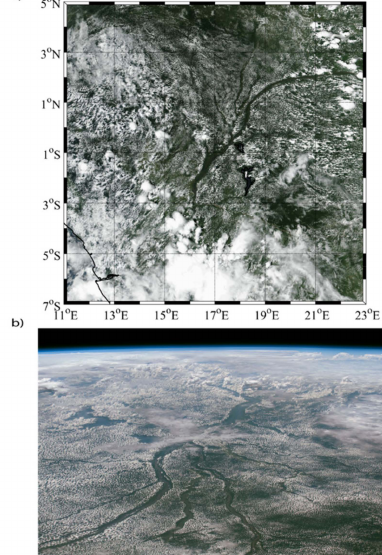
Figure 1. ( a ) True color MODIS satellite image of the Congo Basin centered over the Congo River on 5 November 2018 taken from NASA Worldview. ( b ) Shows the Congo River from the International Space Station (ISS), centered at the same location as the above MODIS image. NASA photo ID: ISS057-E-58903.